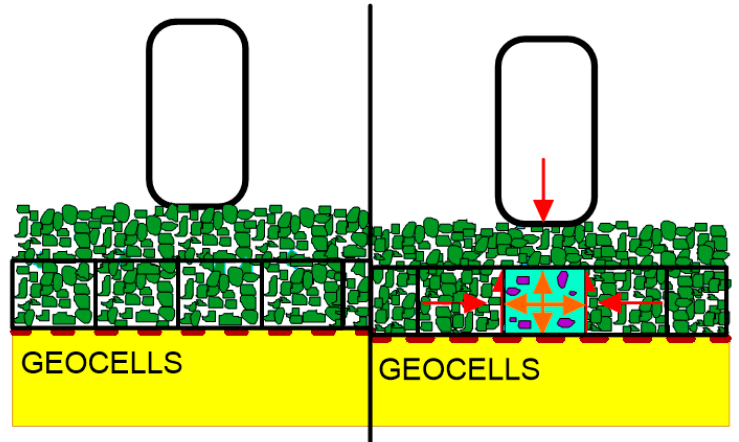
Figure 19. Stabilising mechanism in geocells (adapted from [125]).